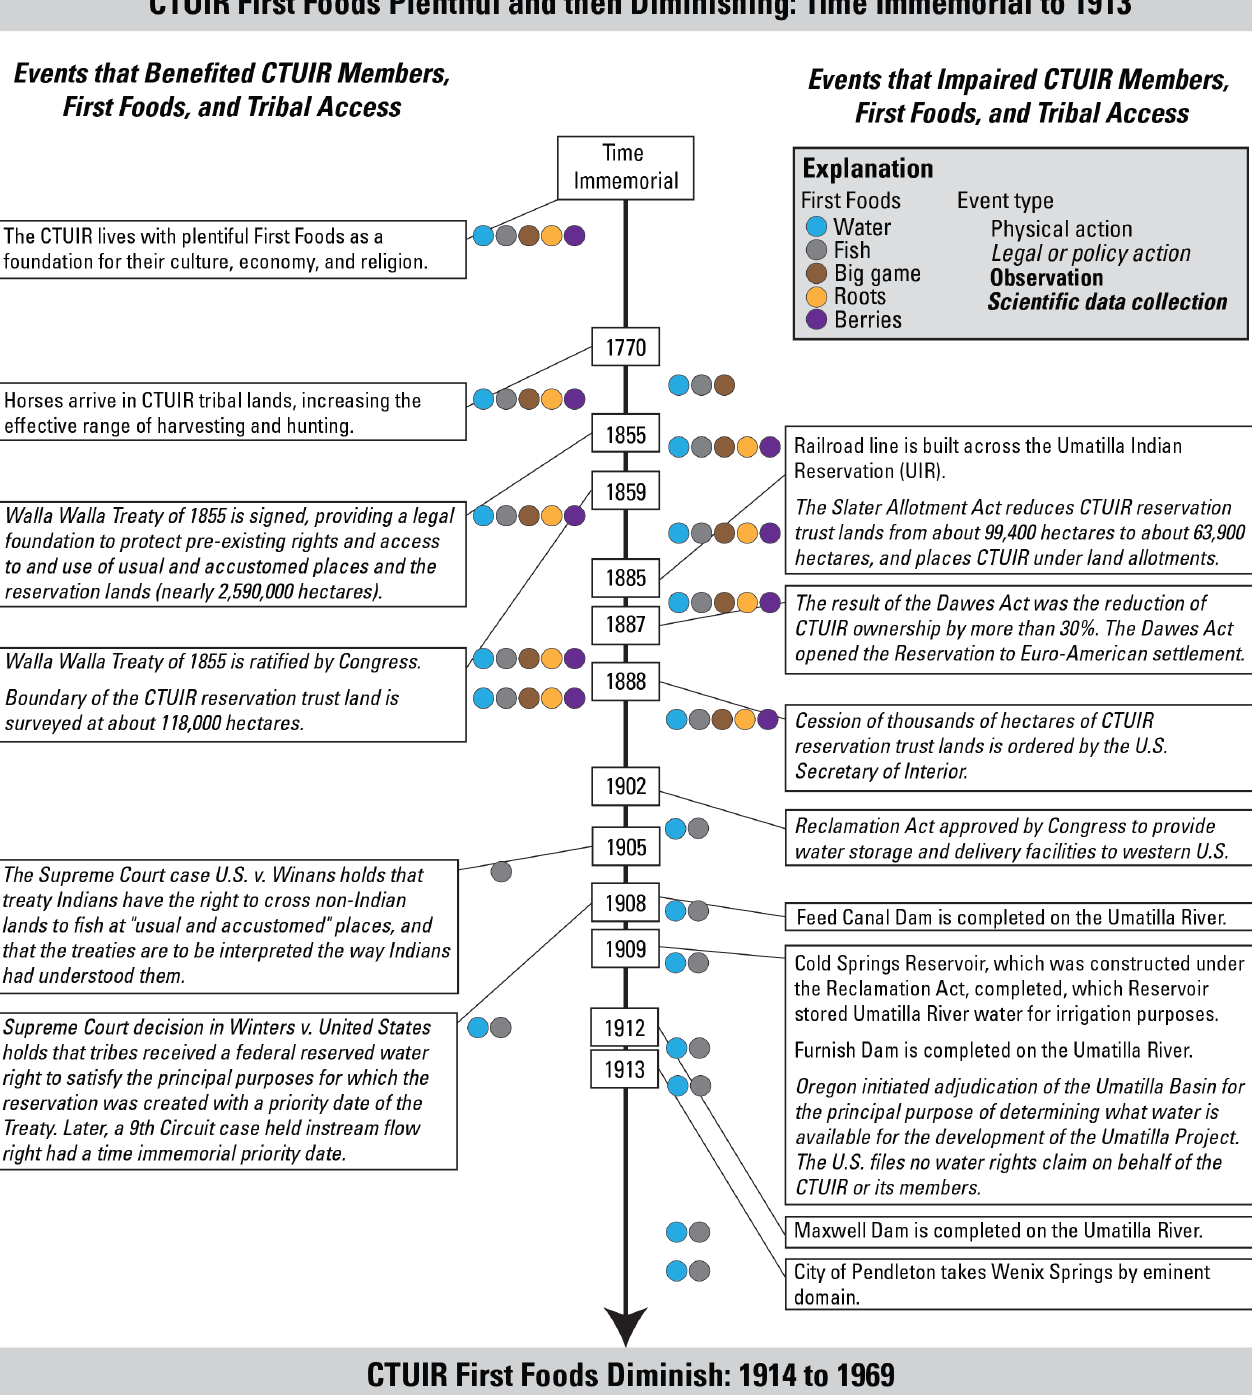
Fig. 4 . Timeline of representative events benefiting or diminishing First Foods and tribal access to them, time immemorial to